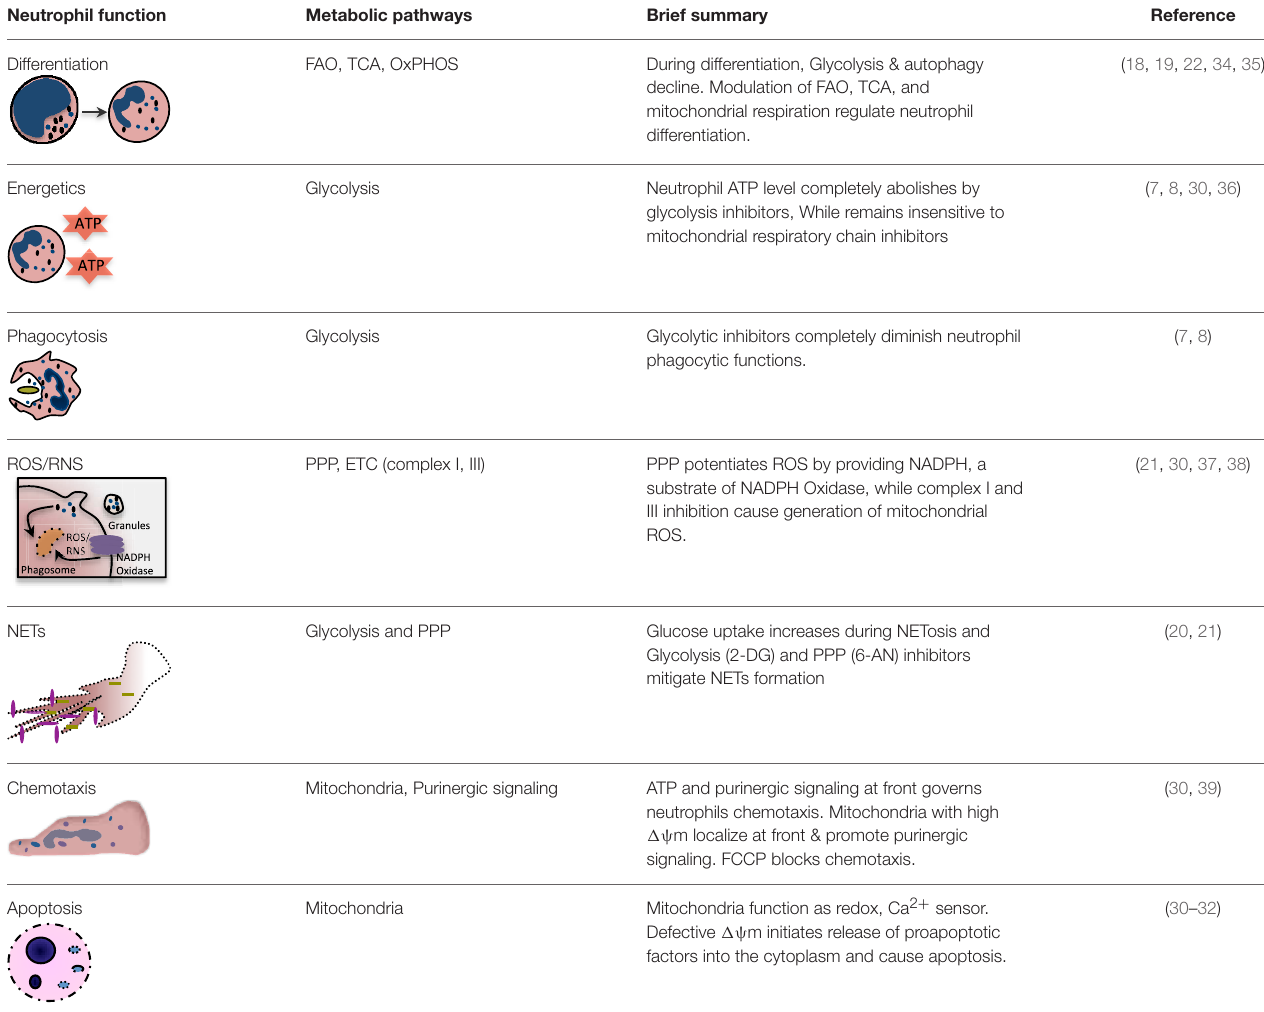
TABLE 1 | Key metabolic pathways regulating distinct neutrophil